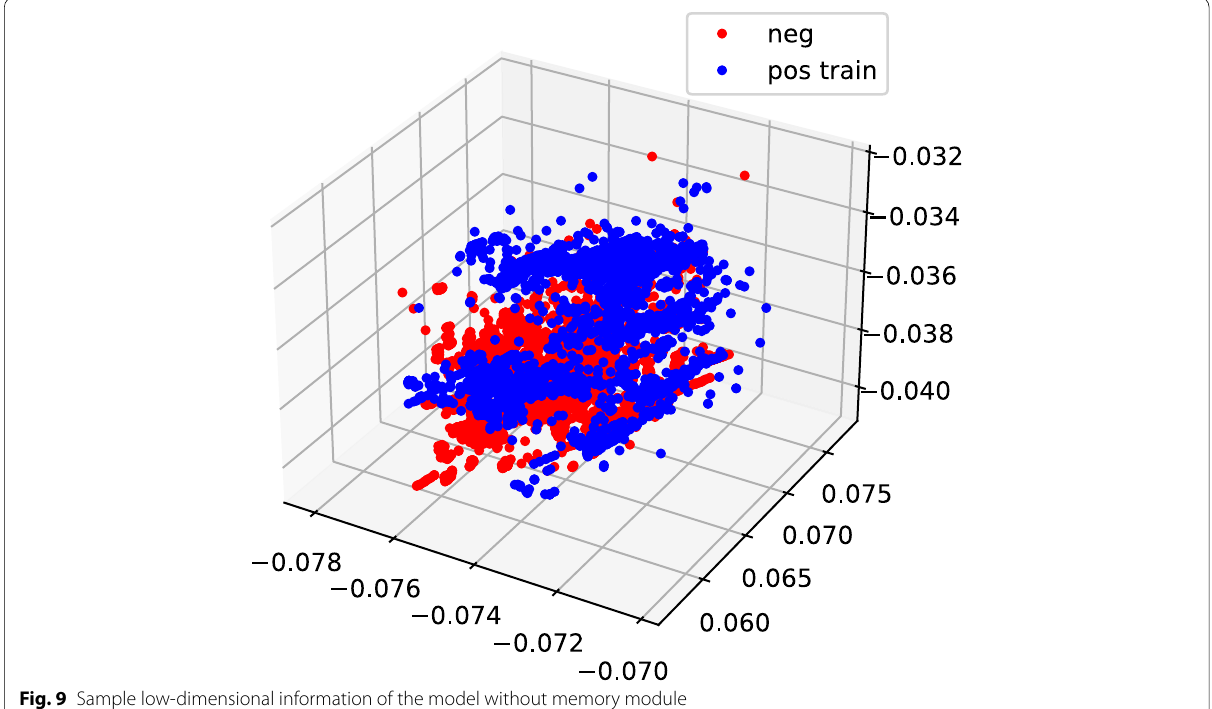
Fig. 9 Sample low-dimensional information of the model without memory module